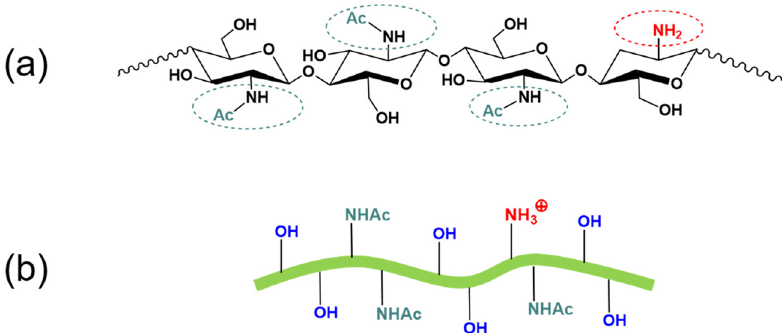
Figure 8: ( a ) Chemical structure of unmodi fi ed chitin; ( b ) scheme of mechanically fi brillated CNFs with protonated amino groups at pH 3